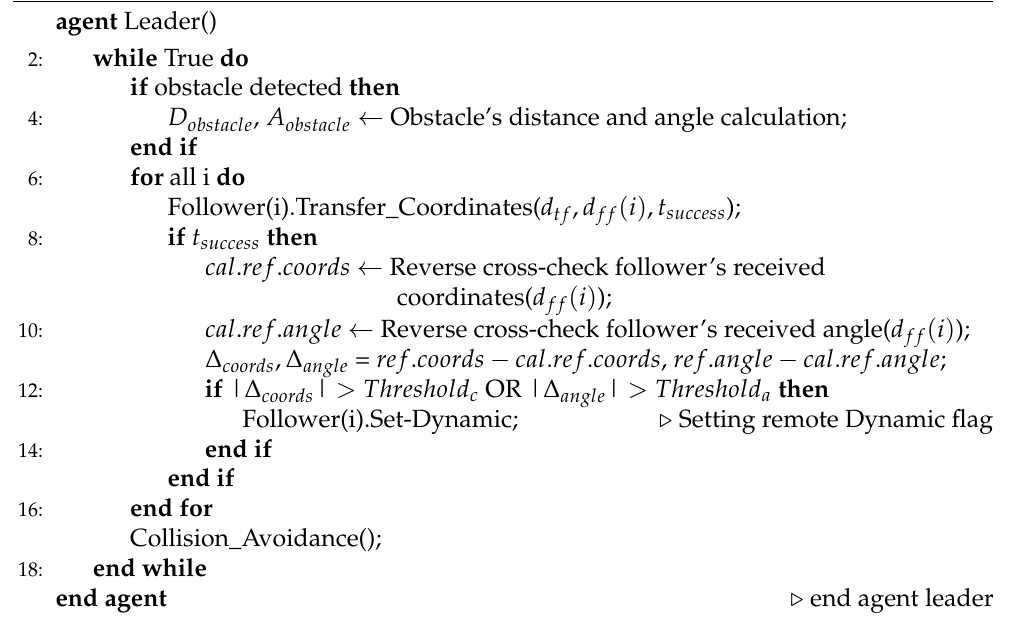
Algorithm 1 Leader: Navigation & Object